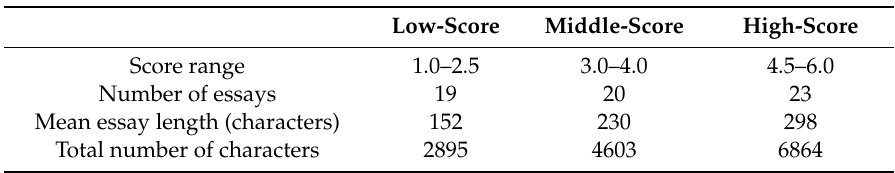
Table 1. Dataset in the current